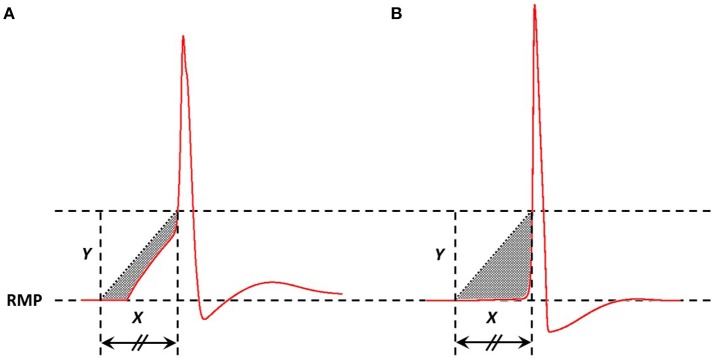
Method adopted to quantify convexity of AP foot. The shaded area indicates the area between the AP curve and the straight line joining the two pre-defined points. Area below the straight line is considered as negative area and that above, if present, as positive (absent in above cases). Here, the signal in (A) has a greater value of convexity than that in (B).